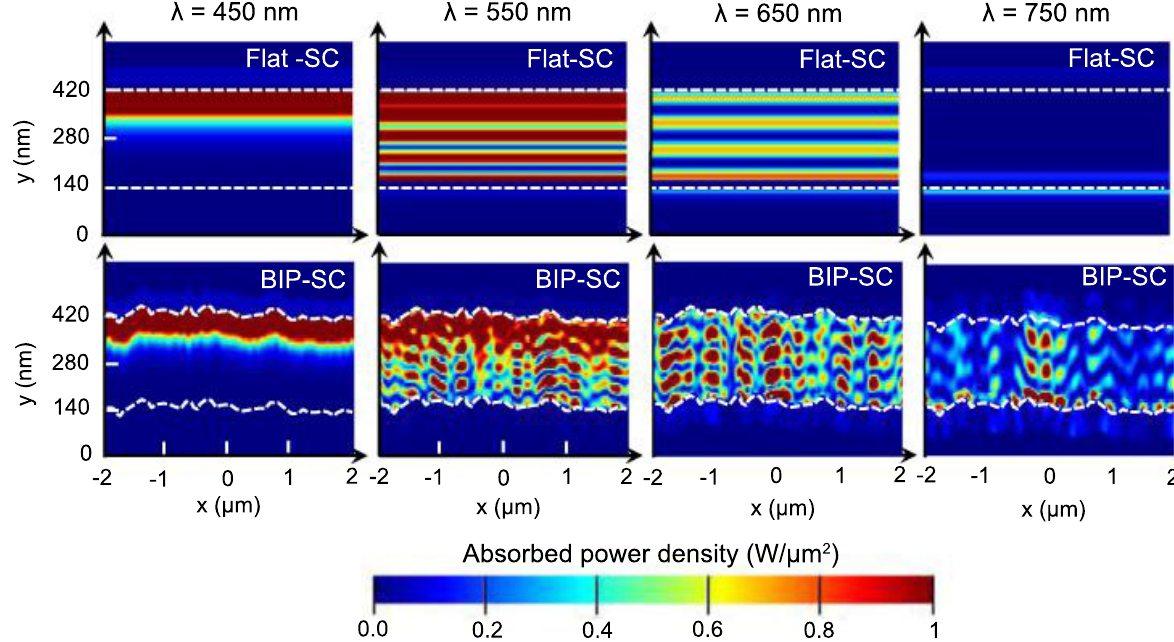
Fig. 6. The calculated optical absorption distribution at wavelength values of 450nm, 550nm, 650nm and 750nm for a-Si:H thin- fi lm solar cells (Flat-SC and BIP-SC). The dotted lines are added to demarcate the a-Si:H thin- fi